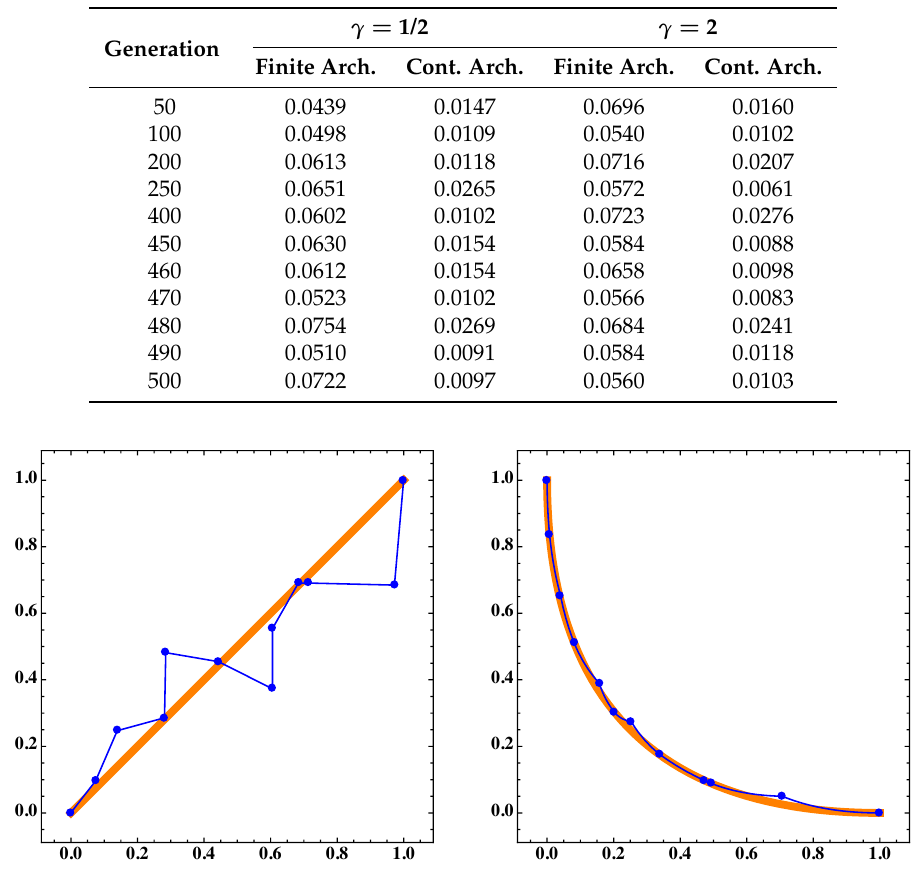
Table 7. For MOP (Equation (16)), the Table shows the ∆ p , q results for the finite and continuous Pareto front approximations. We used the NSGA-II generated archives for p = 1 and q = − 10.